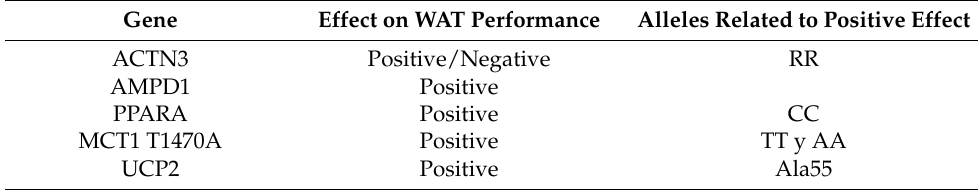
Table 3. Performance-related genes in the WAT. Own elaboration. Gene Effect on WAT Performance Alleles Related to Positive Effect ACTN3 Positive/Negative RR AMPD1 Positive PPARA Positive